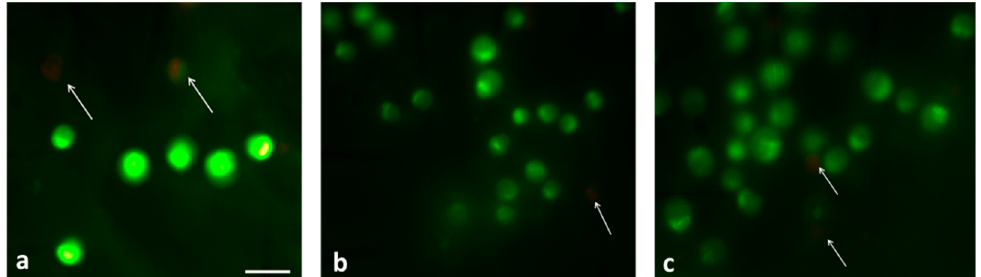
Figure 4. Images of human dental pulp stem cells (hDPSCs) seeded on equine bone blocks, uncoated ( a ), G-N2 ( b ), and G-N10 ( c ), acquired with a fluorescence microscope (40 × ), scale bar 50 µ M. The pictures show that cells are mostly alive (green spots) after 24 h, while only few of them, indicated by the arrows, are dead (red spots). The evaluation of the hDPSC viability was assessed using the live/dead test (Live/Dead BacLight™, Molecular Probes, Eugene, OR, USA).